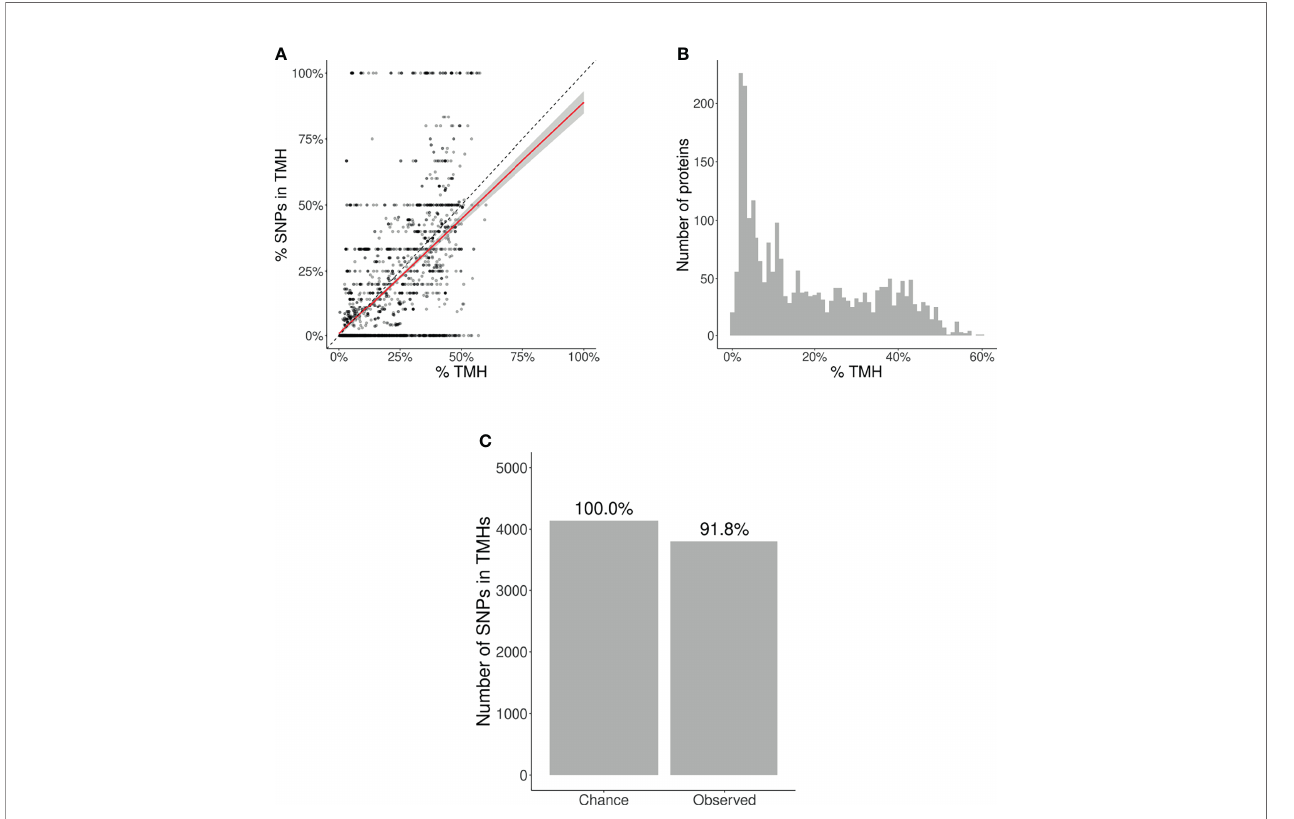
FIGURE 3 | Evolutionary conservation of human TMHs. (A) Percentage of SNPs found in TMHs. Each point shows for one protein the predicted percentage of amino acids that are part of a TMH ( x -axis) and the observed occurrence of SNPs being located within a TMH ( y -axis). The dashed diagonal line shows the line of equality (i.e., equal conservation of TMHs and soluble protein regions). The diagonal red line indicates a linear fi t, the gray area its 95% con fi dence interval. (B) Distribution of the percentages of TMH in the TMPs used in this study. (C) The number of SNPs in TMHs as expected by chance (left bar) and found in the dbSNP database (right bar). Percentages show the relative conservation of SNPs in TMHs found relative to stochastic